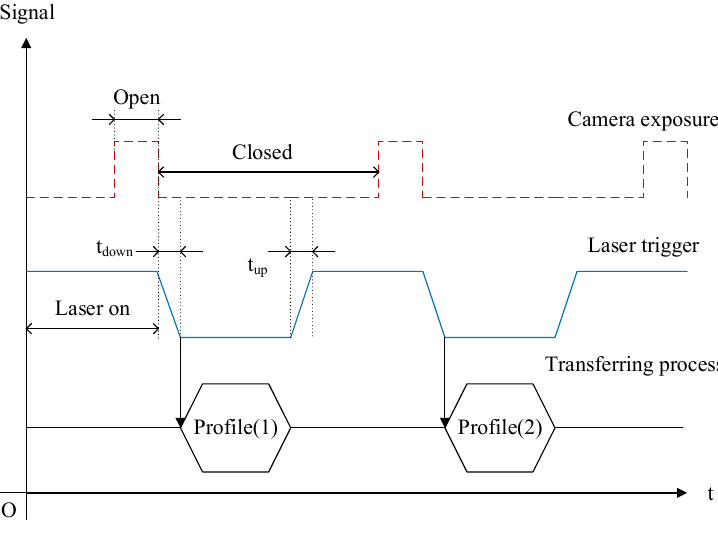
Figure 4. The timing diagrams for image profile generation.